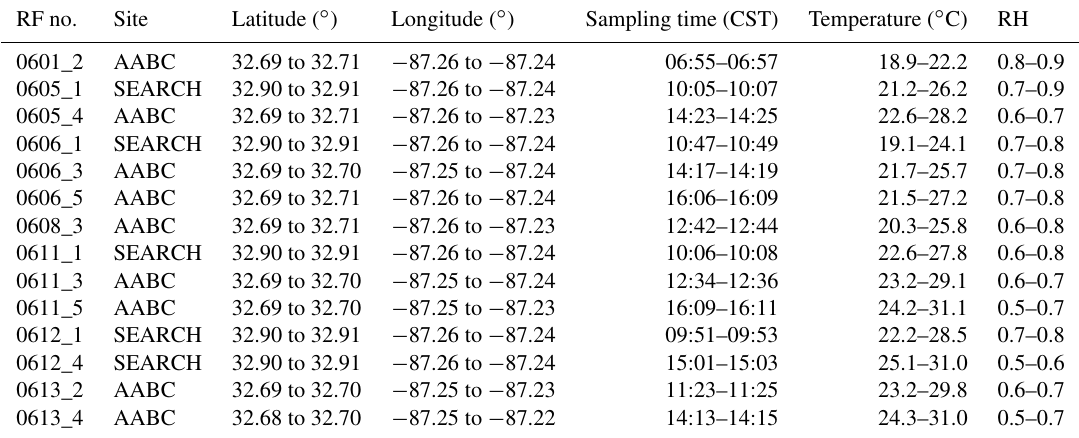
Table 1. Summary of the WASP research flights (RFs). The first four digits in “RF no.” before the underscore indicate the month and day of the flight, while the digit after the underscore indicates the flight number carried out on the specific single day. RF